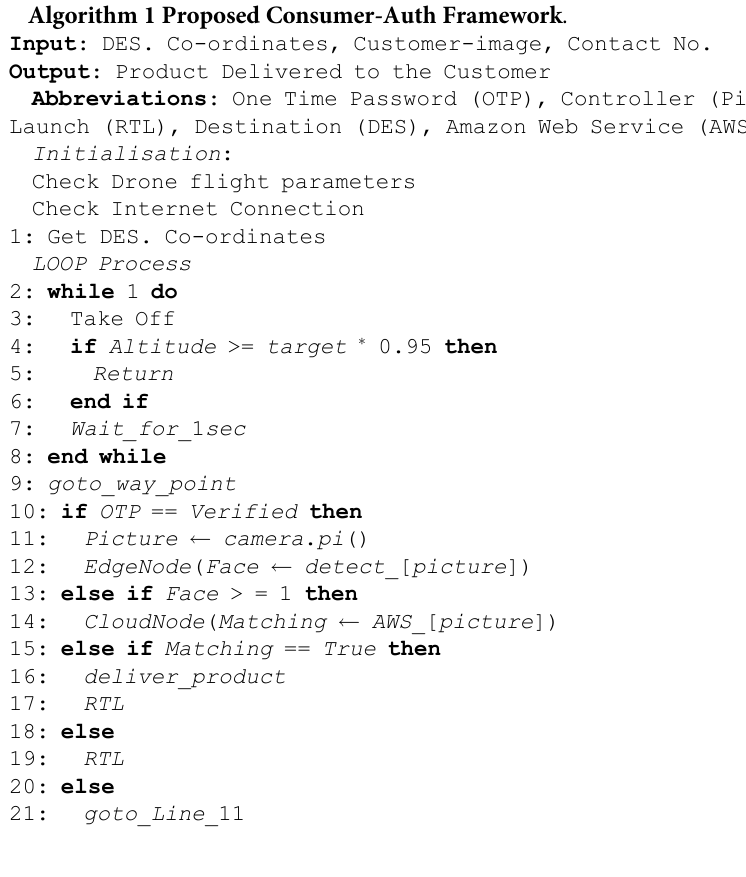
Algorithm 1 Proposed Consumer-Auth Framework